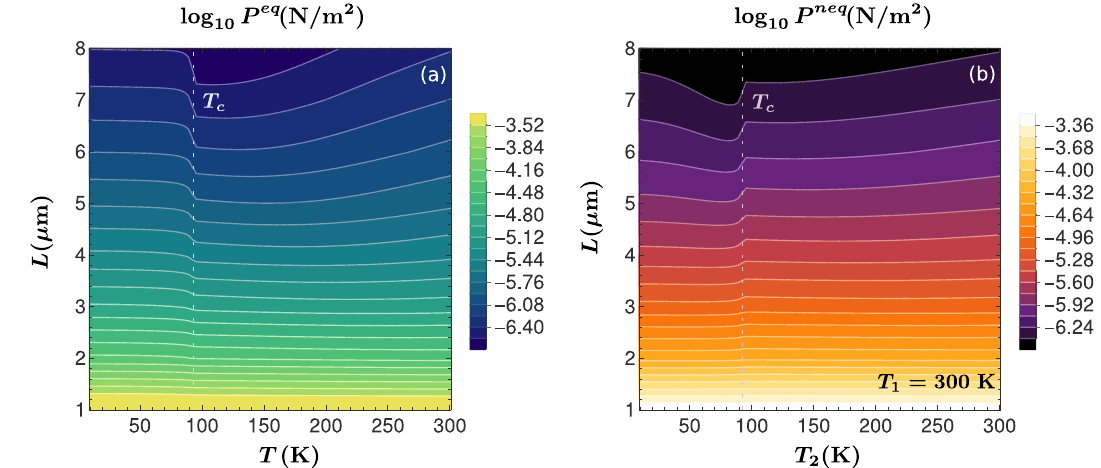
Figure 2. ( a ) Contour plot of the modulus of the equilibrium Casimir pressure (in logarithmic scale), P eq , as a function of the separation distance, L , and the temperature of the YBCO plates, T . ( b ) Contour plot of the modulus of the nonequilibrium Casimir pressure (in logarithmic scale), P neq , as a function of L and the temperature of plate-2, T 2 , for a fixed temperature of plate-1, T 1 = 300